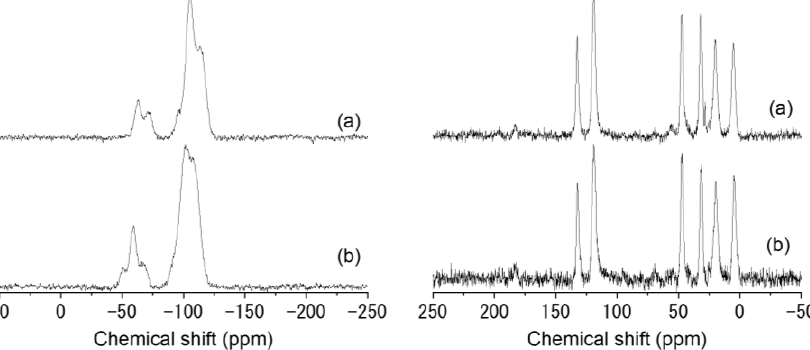
Figure 5. 29 Si ( left ) and 13 C ( right ) CP-MAS NMR spectra of Imi/1Al_SBA-15 ( a ) and Imi/5Al_SBA-15 ( b ). 15 ( b